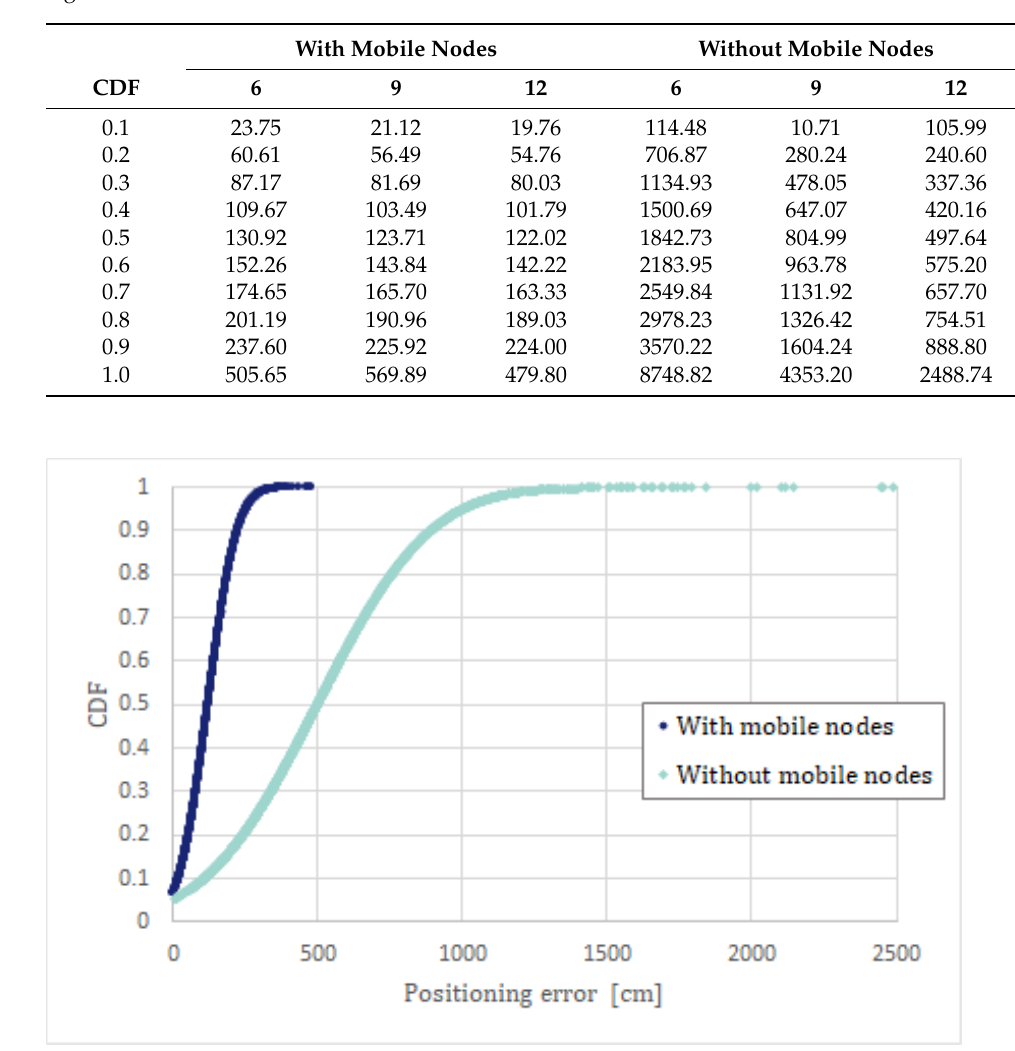
Figure 7. The CDF comparison at the average node degree of